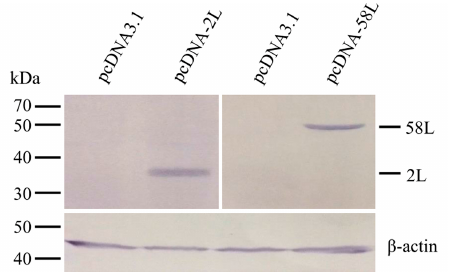
Figure 1. Expression of the 2L and 58L proteins in Epithelioma papulosum cyprinid (EPC) cells. EPC cells were transfected with pcDNA-2L, pcDNA-58L, or pcDNA3.1, and their expression were analyzed by Western blot at 48 h after transfection. The Chinese giant salamander β -actin was used as an internal control.